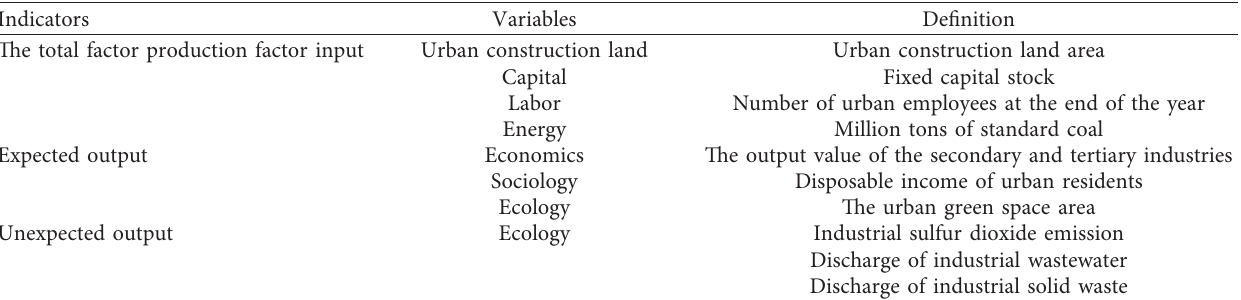
Table 3: Evaluation index of urban construction land utilization efficiency in